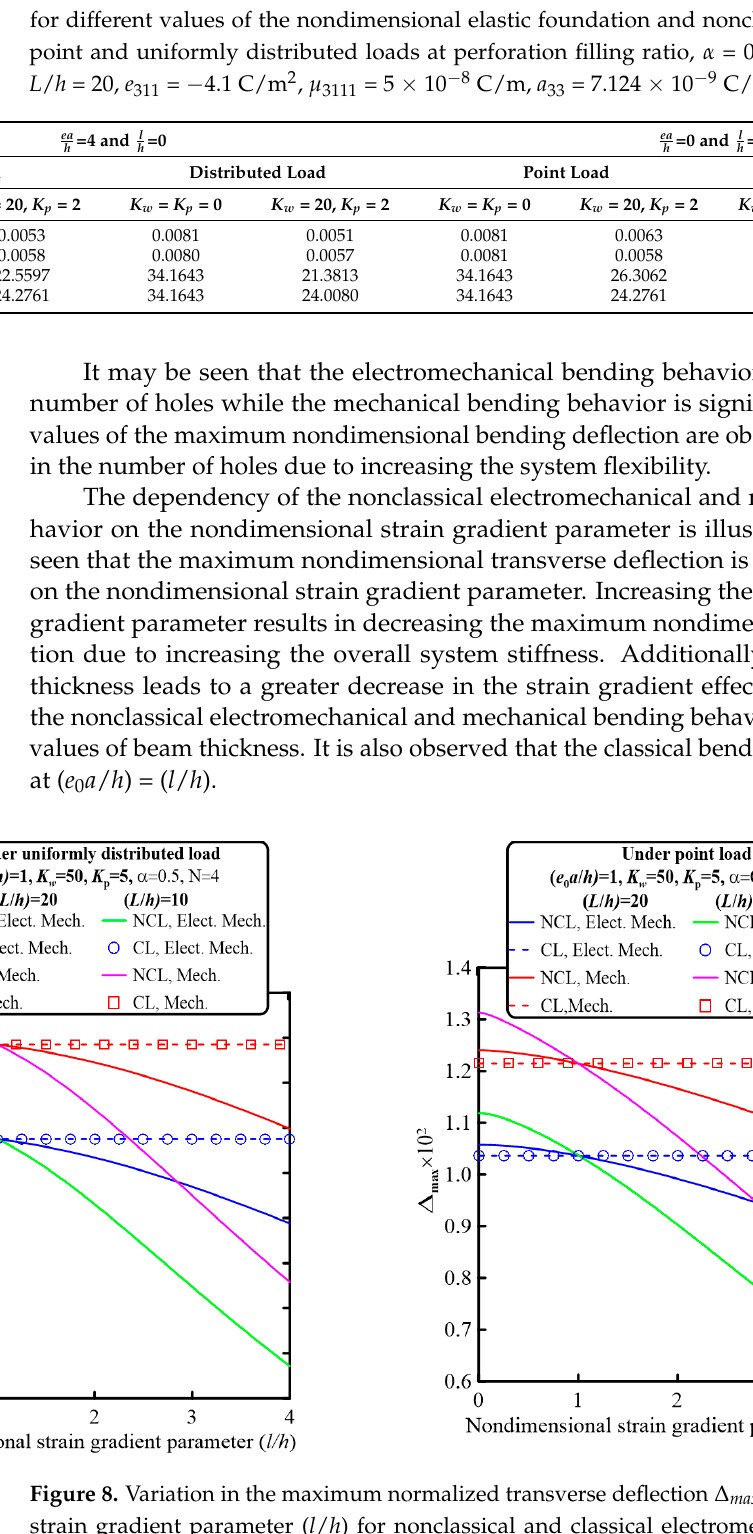
due to increasing N